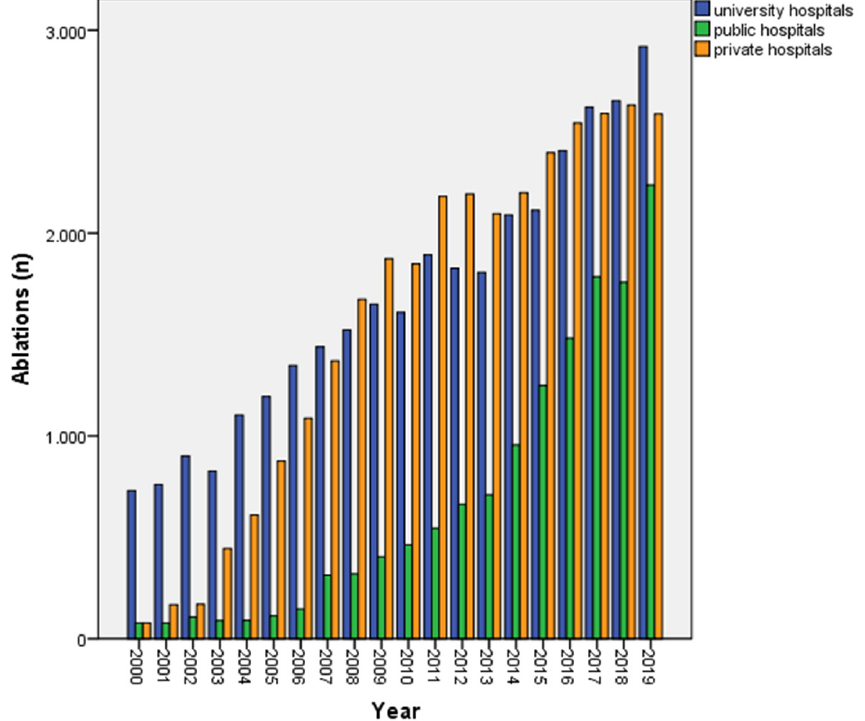
Figure 4. Ablations distributed to ablating centers from 2000 till the end of 2019.